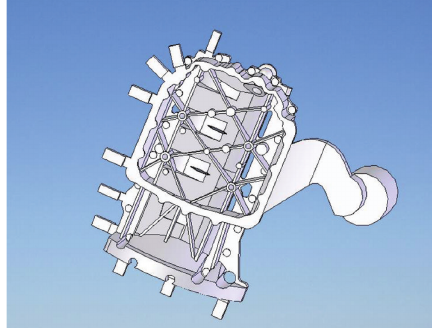
Figure 6: positions of added overflows to the